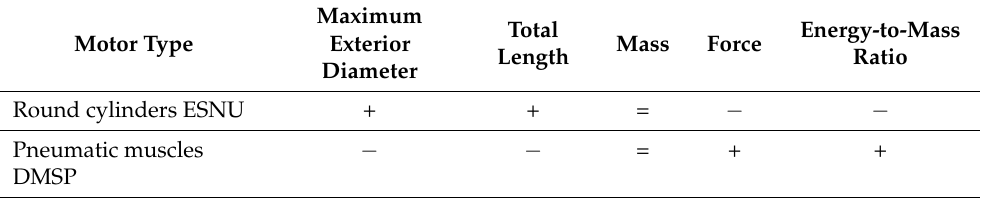
Table 7. Overview of the results obtained by the comparative study of the two types of pneumatic motors. Motor